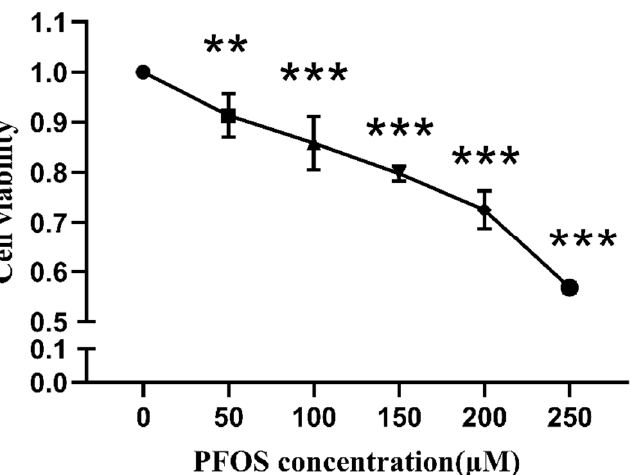
Figure 2. Cell viability after HK-2 cells were exposed to PFOS. HK-2 cells were exposed to PFOS at the concentration of 0 µ M, 50 µ M, 100 µ M, 150 µ M, 200 µ M and 250 µ M for 12 h and CCK-8 was used to detect the cell viability; the results were from three independent experiments. Cell viability was expressed as mean ± SD (n = 3). * vs. control, ** p < 0.01, *** p <